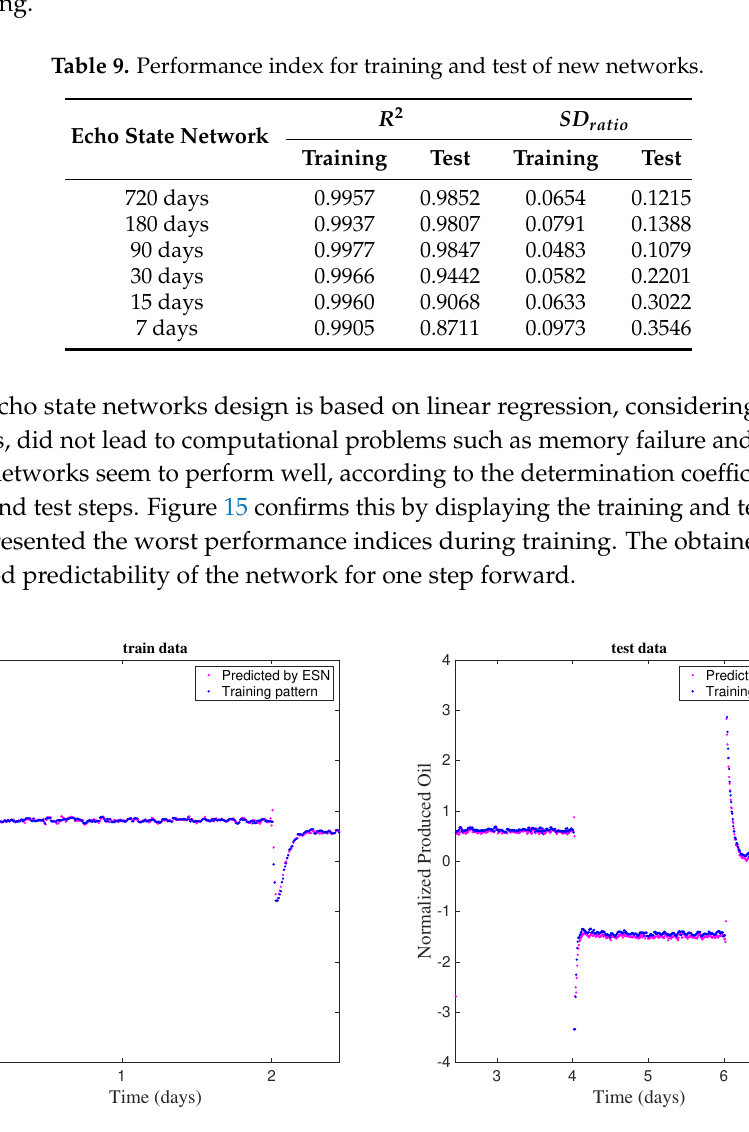
Figure 15. Training and testing of the network designed with the 7-day time